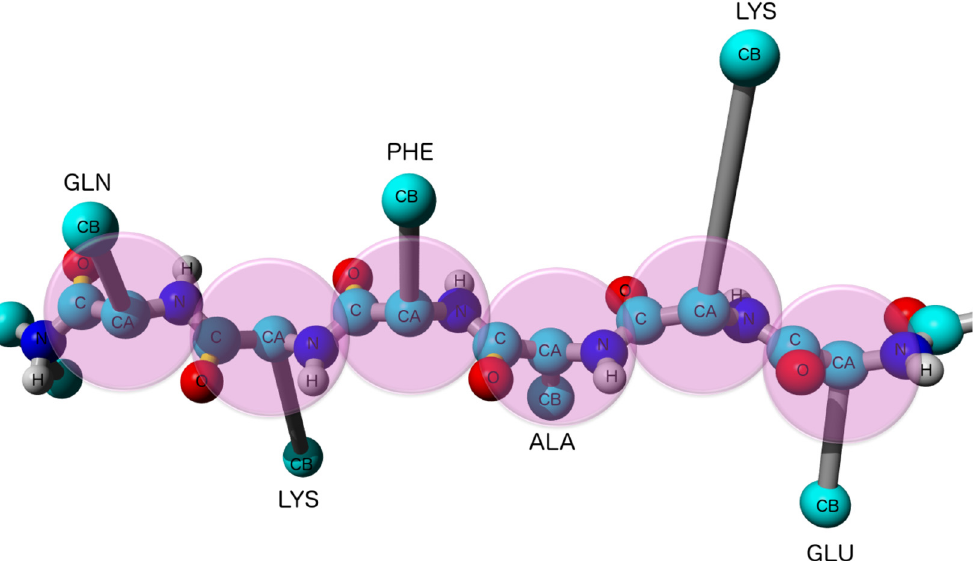
Fig 5. Schematic representation of a segment of a polypeptide chain in the CamTube model. The tube-like implementation is carried out by self- avoiding spheres, which for clarity of illustration are shown here only for C α atoms. Bond lengths (apart from the C α -C β bond) and angles are taken from the Amber force field. The length of the CA-C β bond of Val, Pro, Thr, Ser and Cys is scaled 1.5 times; Asp, Ile, Leu and Asn 2 times; Phe 2.25 times; Glu, Gln, Met and His 2.5 times; Tyr and Trp 3 times; Lys and Arg 4 times the length of the C α -C β bond in the Amber force field.